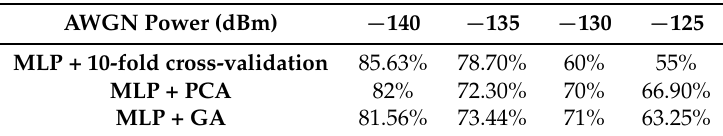
Table 9. Evaluating the robustness of the trained networks in predicting unseen data at different noise levels using BS = 1 and HLN = 30.